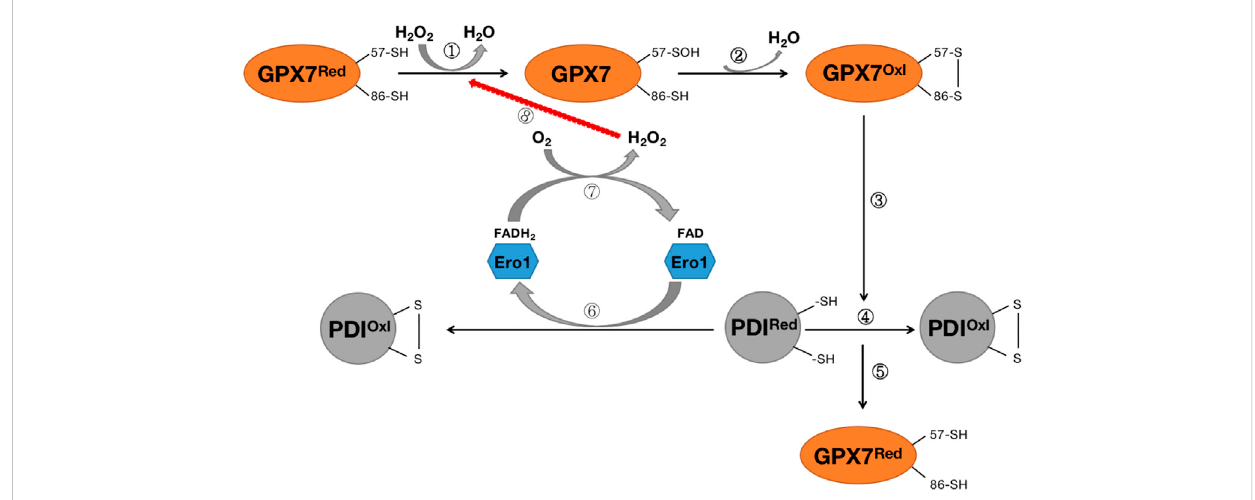
FIGURE 6 Diagram of the Rro1/GPX7/PDI protein folding mechanism. Steps ① - ② : H 2 O 2 converts reduced GPX7 into oxidized GPX7 and releases a subset of H 2 O; Steps ③ - ④ : Oxidized GPX7 can promote the formation of disul fi de bonds on PDI, convert reduced PDI into oxidized PDI, and enhance the activity of PDI; Step ⑤ :P during theoxidation of DI, GPX7is re-transformed from oxidized form to reduced form; Steps (6) – (8): The reduced PDI can beoxidized by endoplasmic reticulum oxidized protein 1 (Ero1) to convert to oxidized PDI, while transferring 2 electrons to O 2 , thereby forming H 2 O 2 , which again participates in the oxidation process of GPX7. GPX7 Red stands for reduced glutathione peroxidase 7; GPX7 Oxl stands for oxidized glutathione